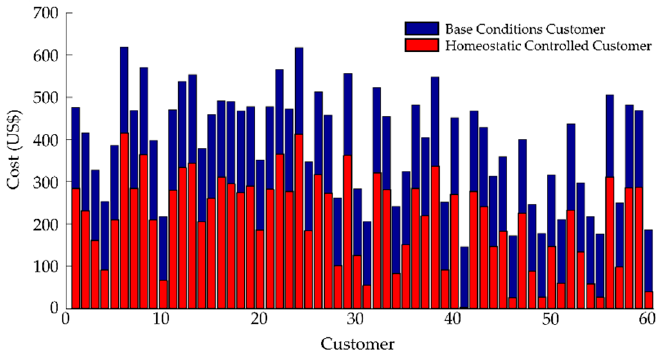
Figure 7. Energy monomic cost in both scenarios: off-peak hours and peak hours’ consumption.